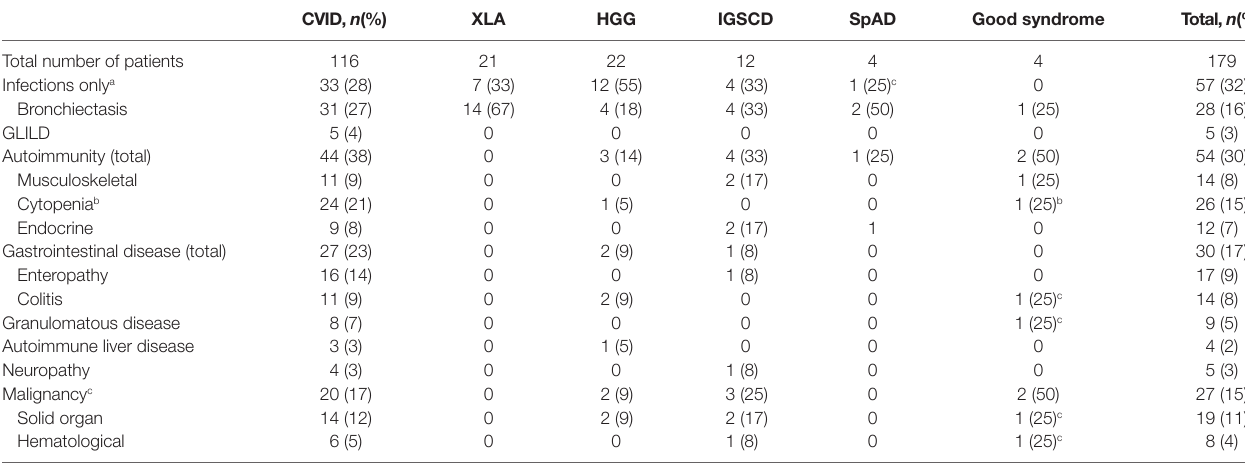
TaBle 2 | Complications in Victorian adults with predominantly antibody